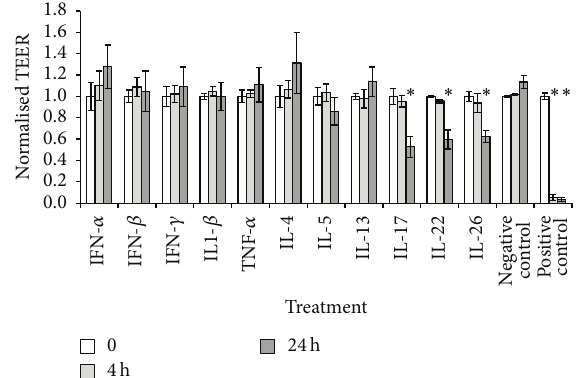
Figure 1: The Th17 cytokines IL-17, IL-22, and IL-26 cause a time- dependent reduction in TEER. Effect of Interferons 𝛼 , 𝛽 , and 𝛾 and of Th1, Th2, and Th17 cytokines on epithelial barrier func- tion determined by measuring transepithelial electrical resistance (TEER) before the addition of cytokines ( 𝑡 = 0 ), and after 4 and 24 h. The values are shown as mean ± SEM for 𝑛 = 4 . Treatments significantly different from the untreated control at 𝑝 < 0.05 are presented as ∗ . ANOVA, followed by Tukey HSD post hoc test.